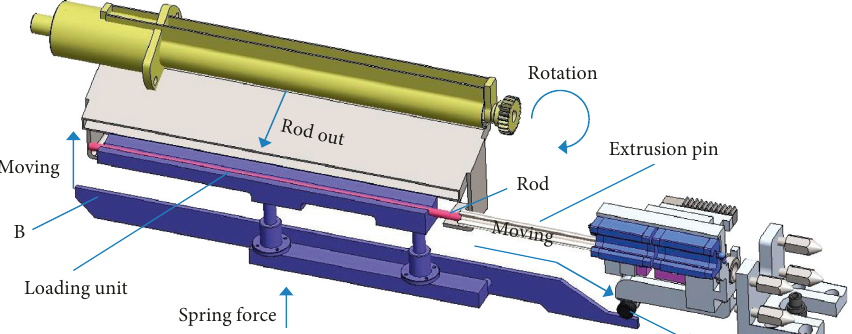
Figure 16: Rod-cut loading mechanism.